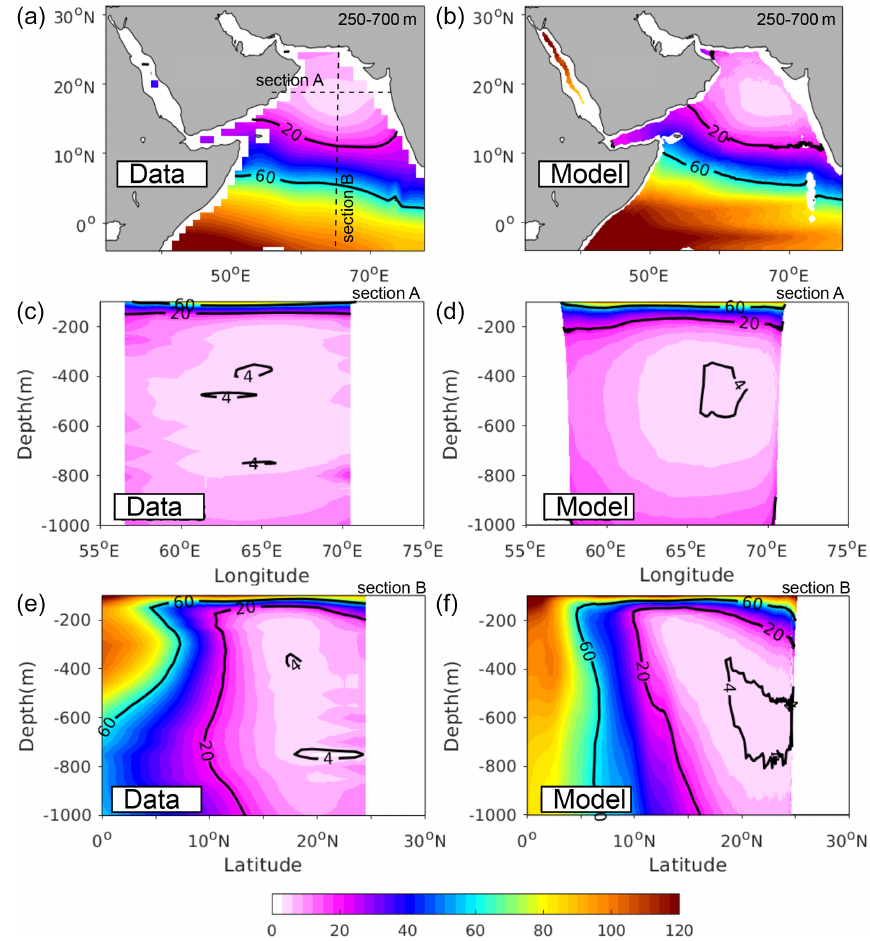
Figure 1. Evaluation of simulated oxygen. Annual mean O 2 (in mmolm − 3 ) (a, b) averaged between 250 and 700m and along (c, d) zonal section A at 18 ◦ N and (e, f) meridional section B at 65 ◦ E as simulated in the model (a, c, e) and from the WOA-2018 dataset (b, d, f)